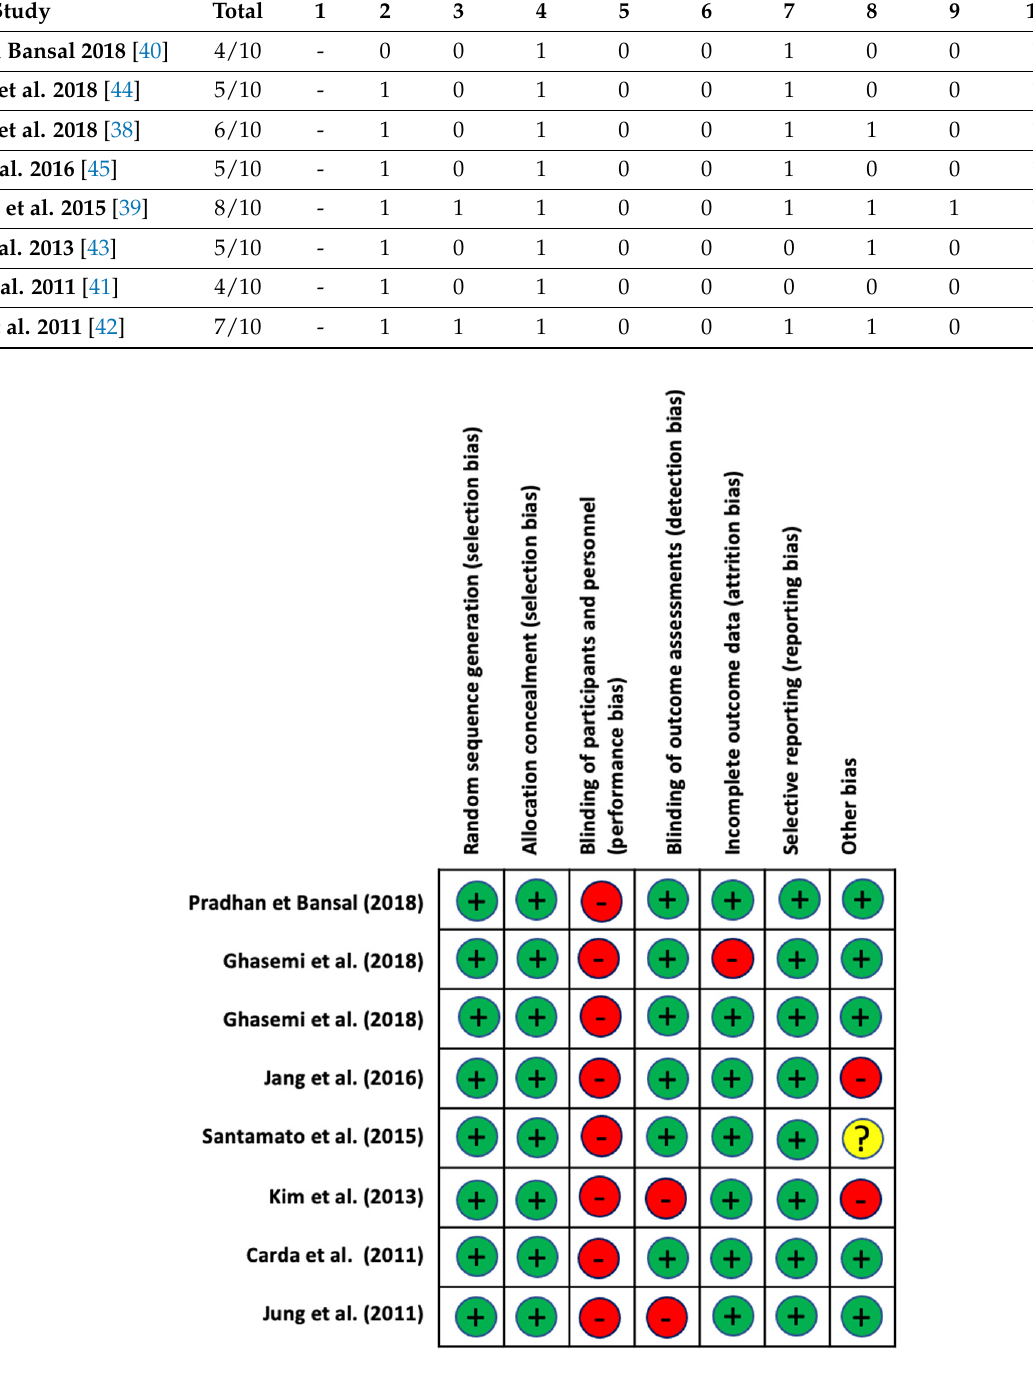
Figure 2. Risk of bias of the studies included in the systematic review.